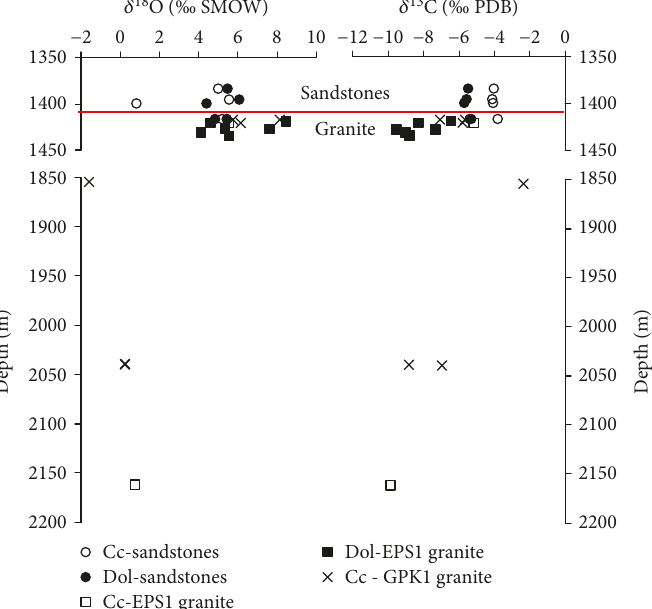
fl uid data are calculated at equilibrium with calcite and